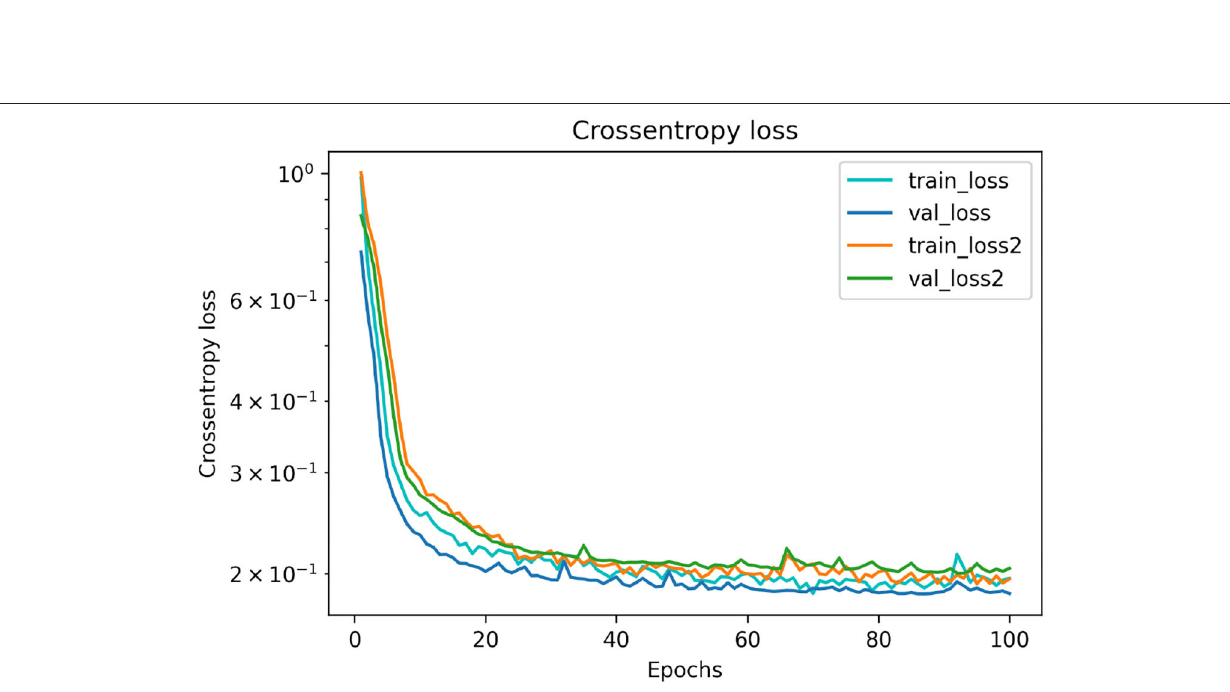
FIGURE A2 | Cross entropy loss of Q-CNN02-DS-OP for the training and validation samples, in cyan and blue, respectively. The best model was found at epoch 88. The cross entropy loss curves obtained using bootstrapping are overlaid in orange and green, respectively, with the best model found at epoch 92. This comparison further demonstrates that the uncertainty on the accuracy of the network is relatively